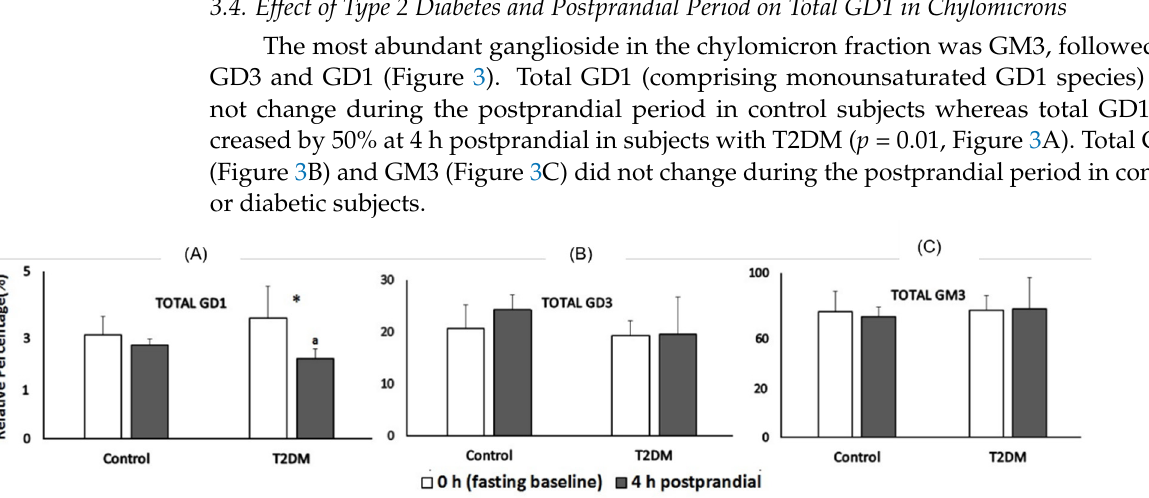
Figure 3. Gangliosides present in chylomicrons at fasted and 4 h postprandial. ( A ) Relative percent of total GD1 in chylomicron fraction at fasting and 4 h postprandial in control and T2DM groups ( p = 0.01). ( B ) Relative percent of total GD3 in chylomicrons at fasting and 4 h postprandial in control and T2DM groups. ( C ) Relative percent of total GM3 in chylomicrons at fasting and 4 h postprandial in control and T2DM groups. Low and high fat diet treatments were combined in subsequent analysis since no significant difference was detected in these groups. Total GD1 = monounsaturated GD1 species. Total GD3 = saturated and monounsaturated GD3 species. Total GM3 = saturated, monounsaturated and polyunsaturated GM3 species. Data represent mean ± SD. Letters ( a,b ) indicate significant difference at p < 0.05 when individual ganglioside species are compared between control and T2DM subjects and symbol (*) indicate significant difference at p < 0.05 when individual ganglioside species are compared at 0 and 4 h time periods in the same group.